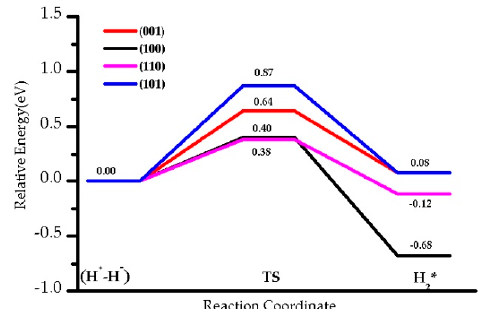
Figure 10. The energy profile of hydrides TiH (H + -H − ) species recombination with OH to desorb H 2 on four facets at 0 K, U = 4 eV.